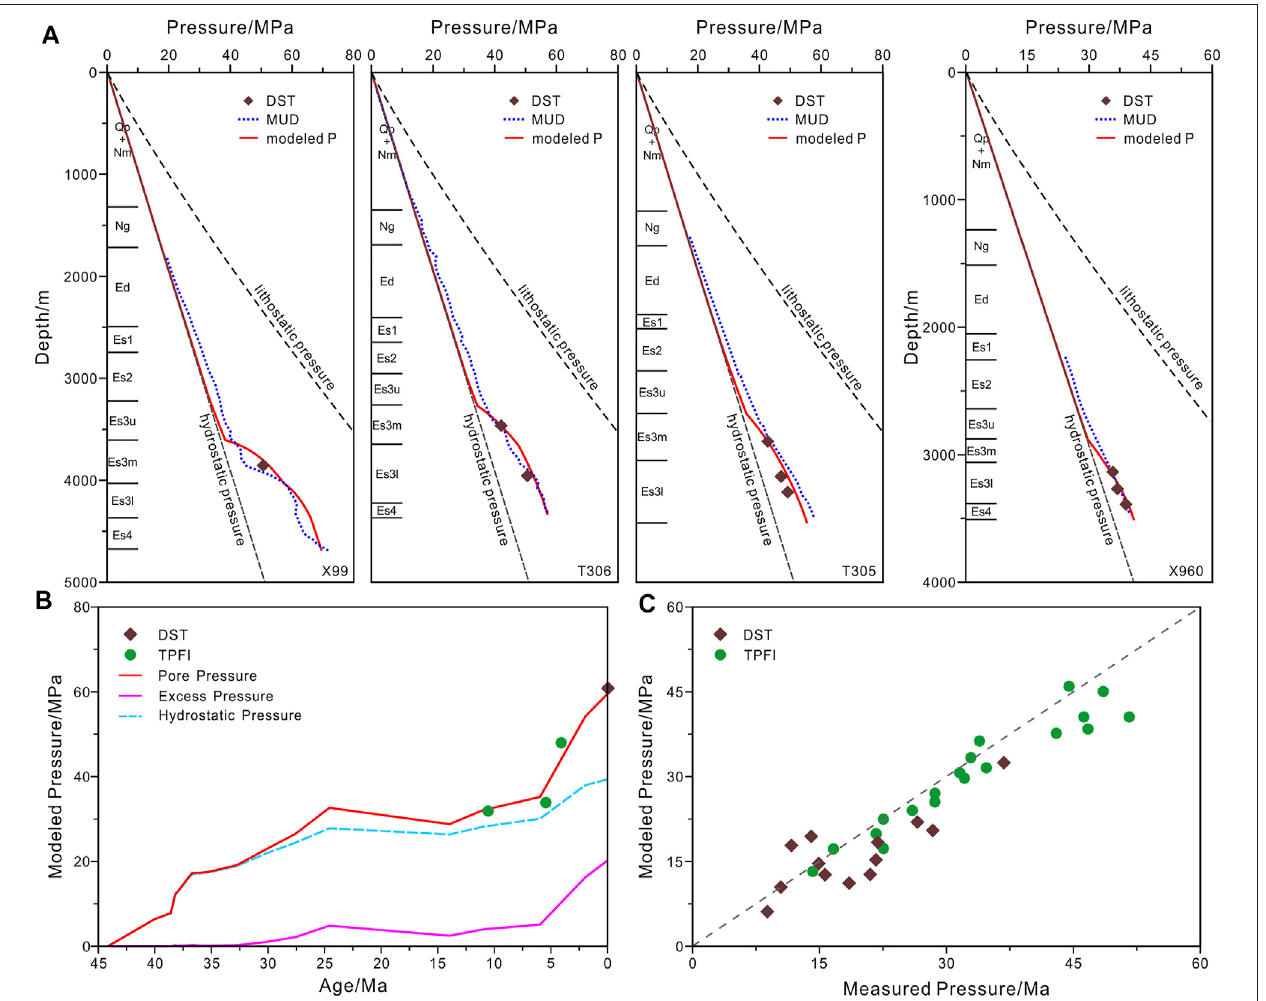
FIGURE 8 | Calibration of pore pressure modeling in the Linnan Sag showing good correlations among the measured pressures, fl uid inclusion pressures, and modeled pressures. (A) Calibration of pore pressure modeling for four wells in the Linnan Sag. (B) The evolution of pore pressure and calibration results. (C) The comparison of the DST, TPFI, and modeled pressures of Es3l. The well locations are shown in Figure 1 .